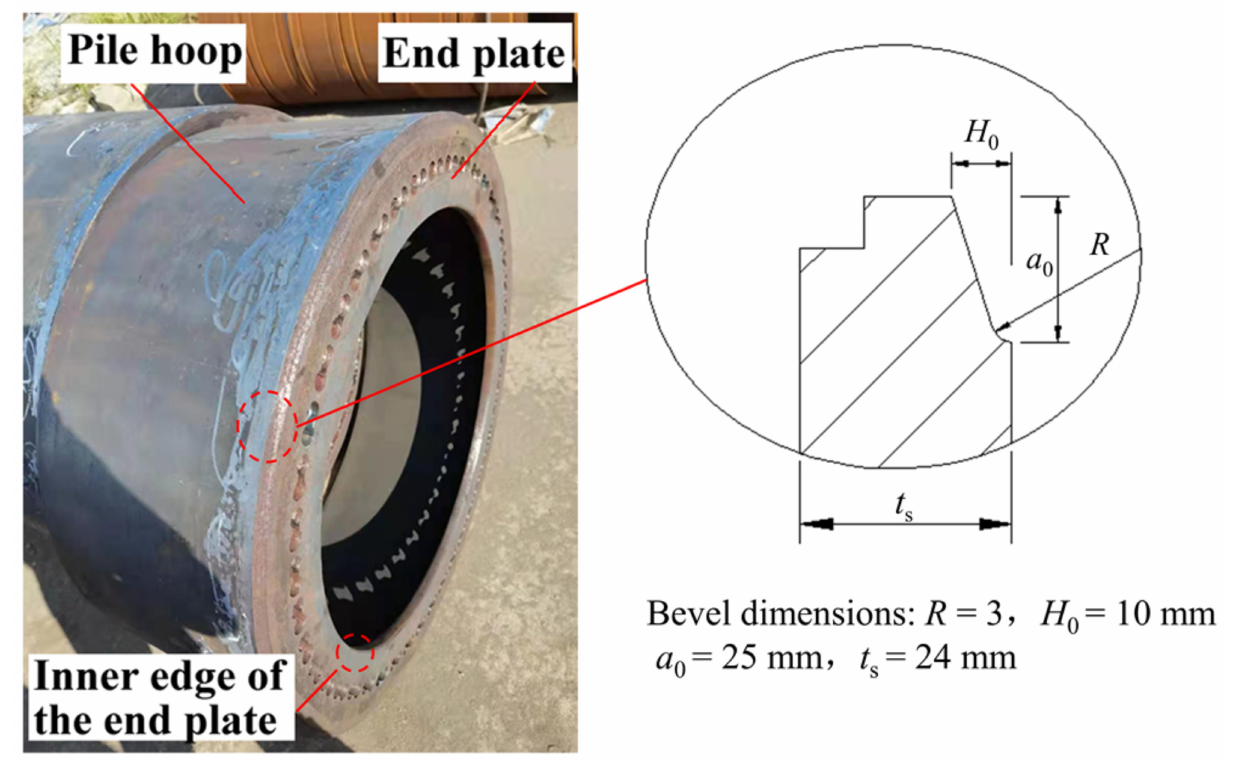
Figure 2. Construction of pipe pile joint. Table 1. Test parameters of PRC